Question: Name the type of graph shown.
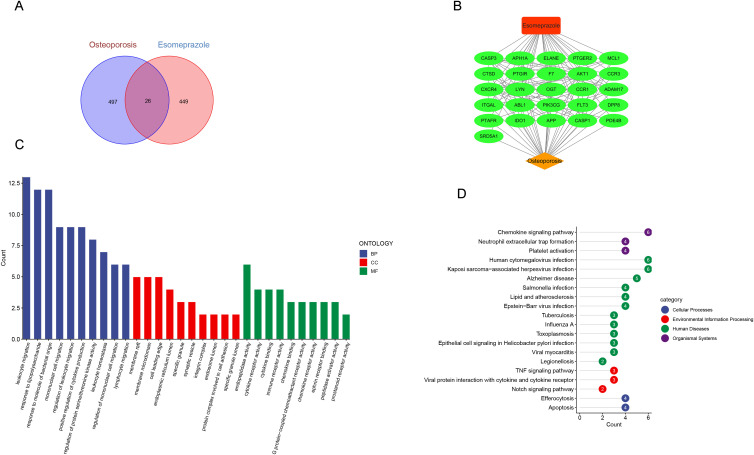
Answer: bar